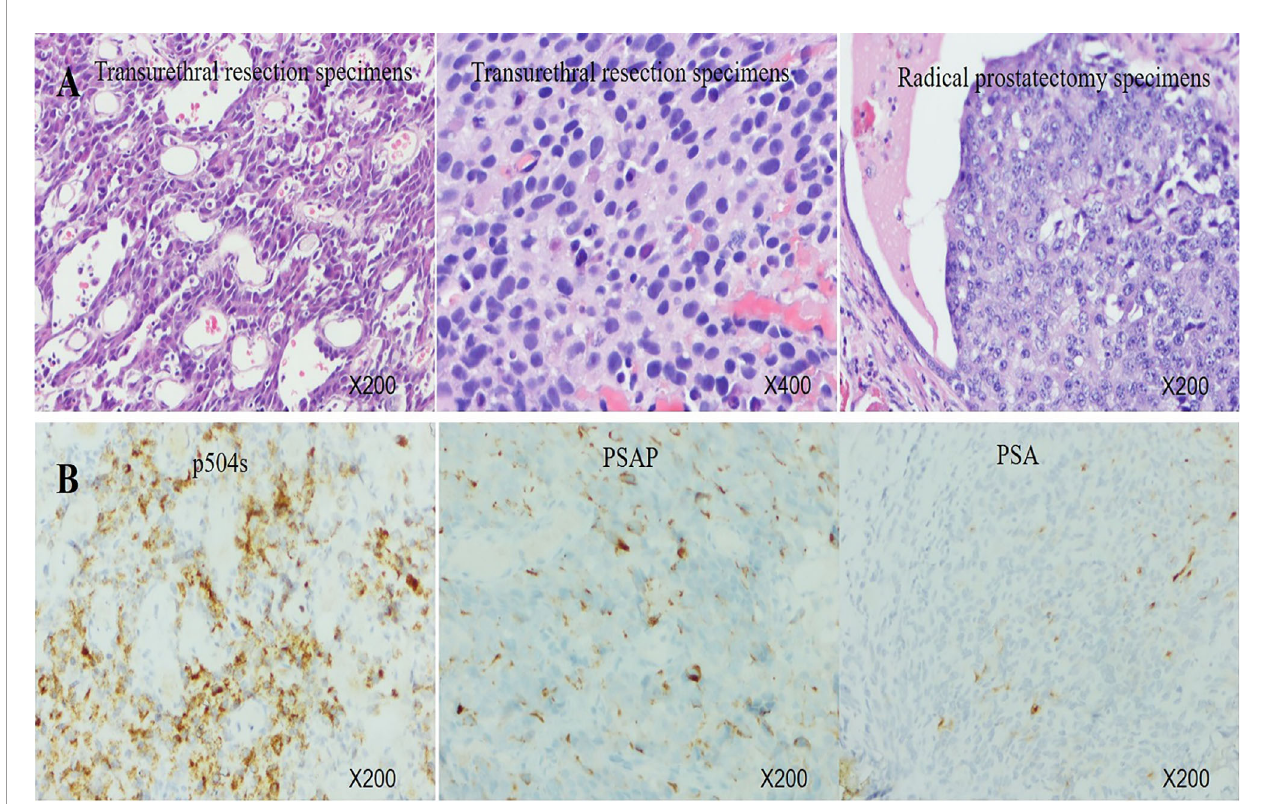
FIGURE 1 | (A) Histology of transurethral resection specimens and radical prostatectomy specimens. (B) Immunohistochemistry of transurethral resection specimens showed very strong expression of P504S, middle expression of PSAP, and focal positivity for